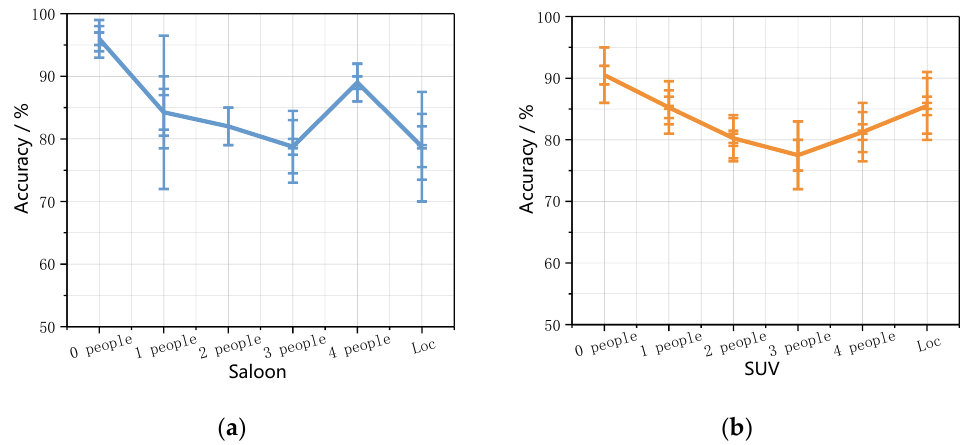
Figure 13. Effect of different vehicle environments on recognition accuracy: ( a ) Vehicle; ( b ) SUV.